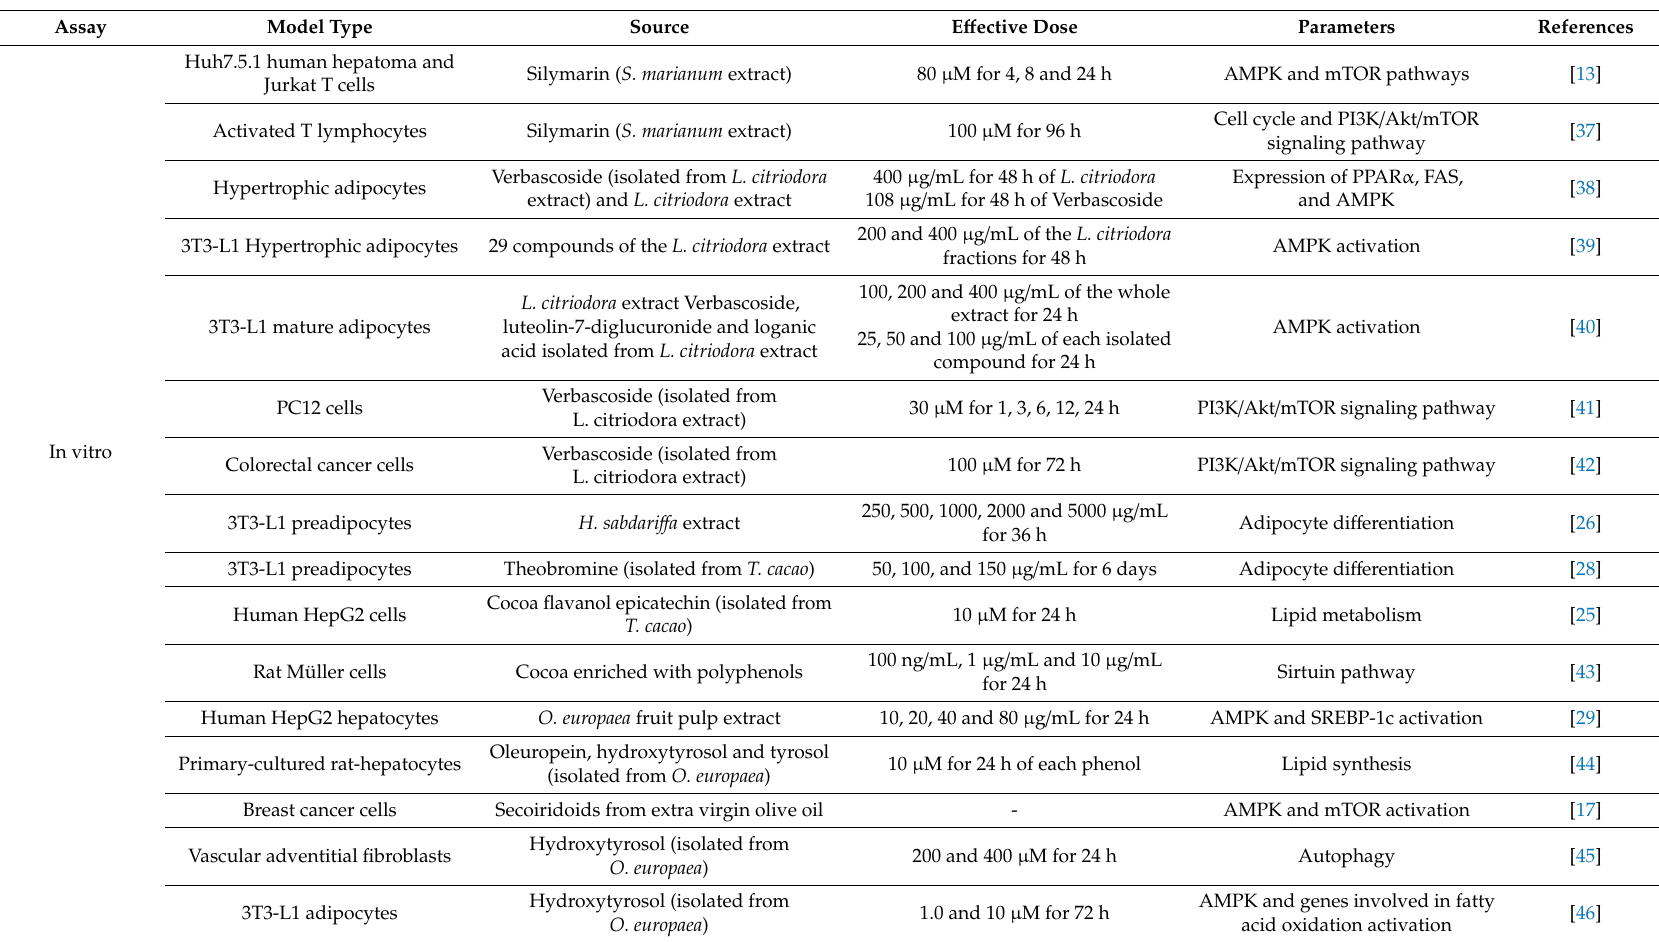
Table 1. Main parameters of the tests that show the e ff ect of selected plant on the main metabolic pathways related to energy